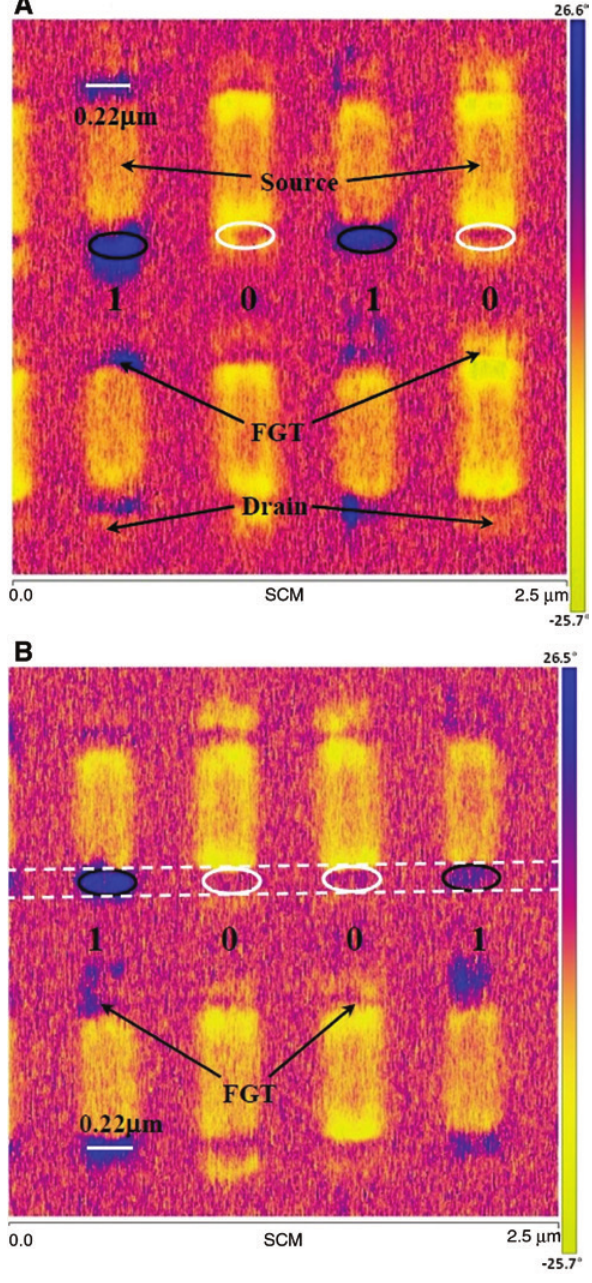
Figure 15: Two SCM scan images over a 2.50 μ m distance of the embedded NOR flash memory device. The preprogrammed word data (A) “AA” = “1010” in binary form, and (B) “CC” = “1001” in binary form, can be read directly from the SCM images. The stored dynamic charges are identified to be present on FGs for “1b” while absent on the FGs for “0b”.